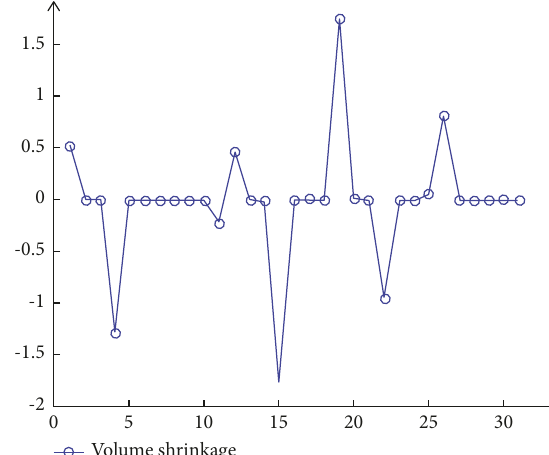
Figure 26: Optimized volume shrinkage error diagram.